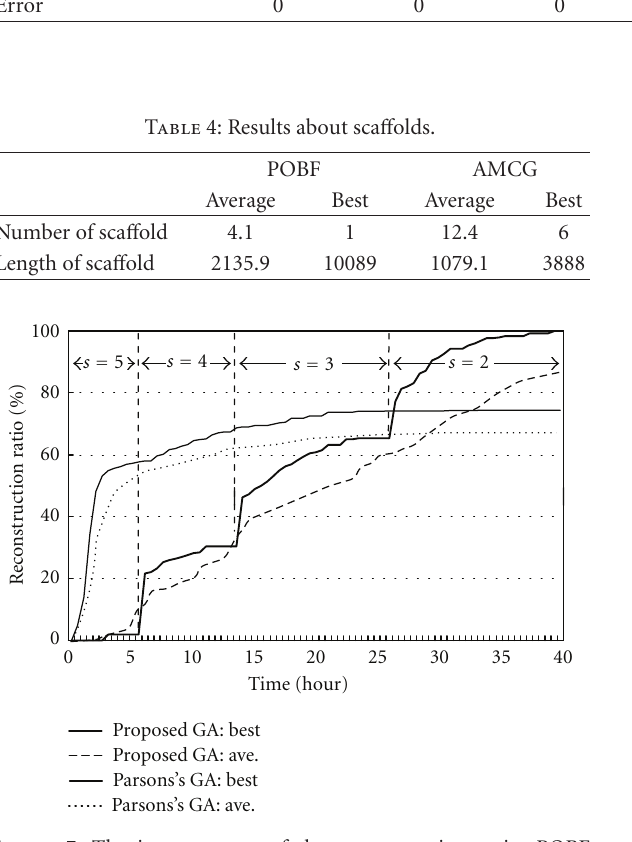
Figure 7: The improvement of the reconstruction ratio: POBF dataset.